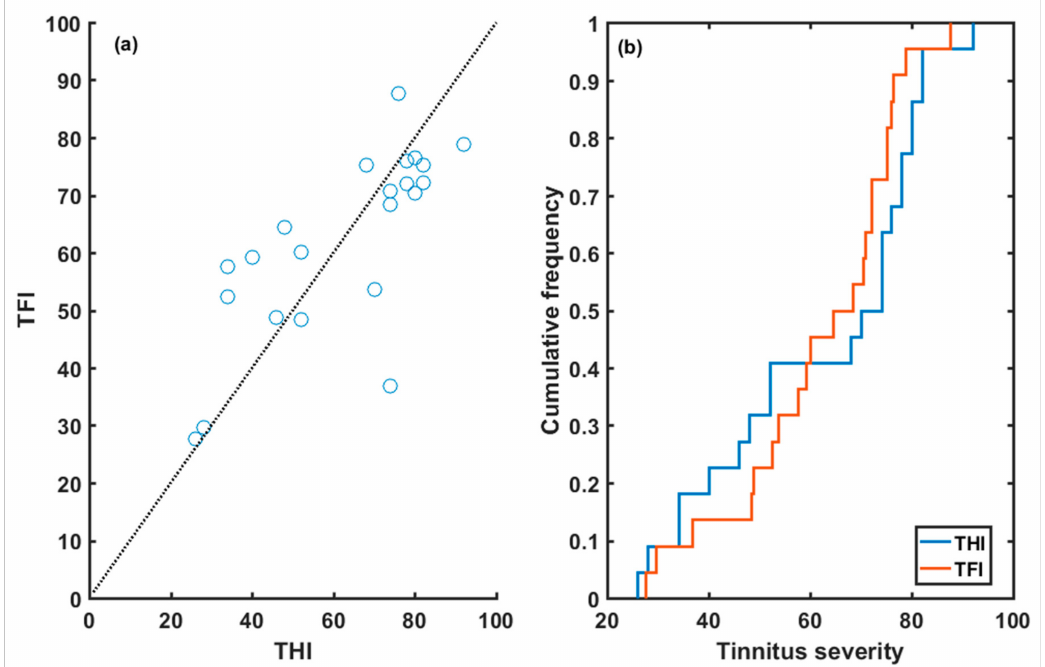
Figure 4. ( a ) Scatter plot and ( b ) empirical cumulative distribution functions of baseline THI and TFI